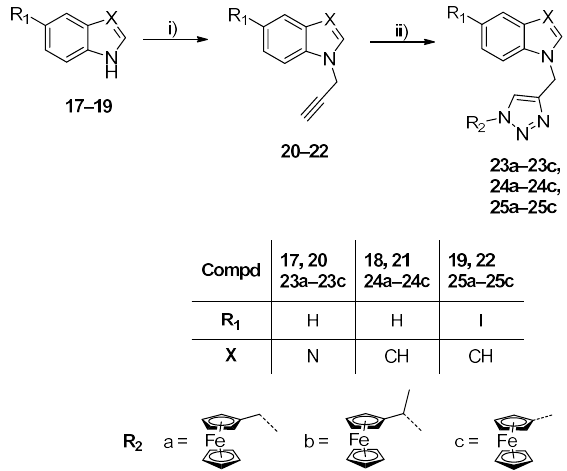
Scheme 2. Synthesis of novel benzimidazole and indole derivatives linked to C-4 of 1,2,3-triazolyl ferrocene. Reagents and conditions : (i) propargyl bromide, NaH, anhydrous DMF, Ar atmosphere, 60 °C, 24 h; (ii) corresponding azide, Cu(OAc) 2 , methanol, room temperature, 24 h.